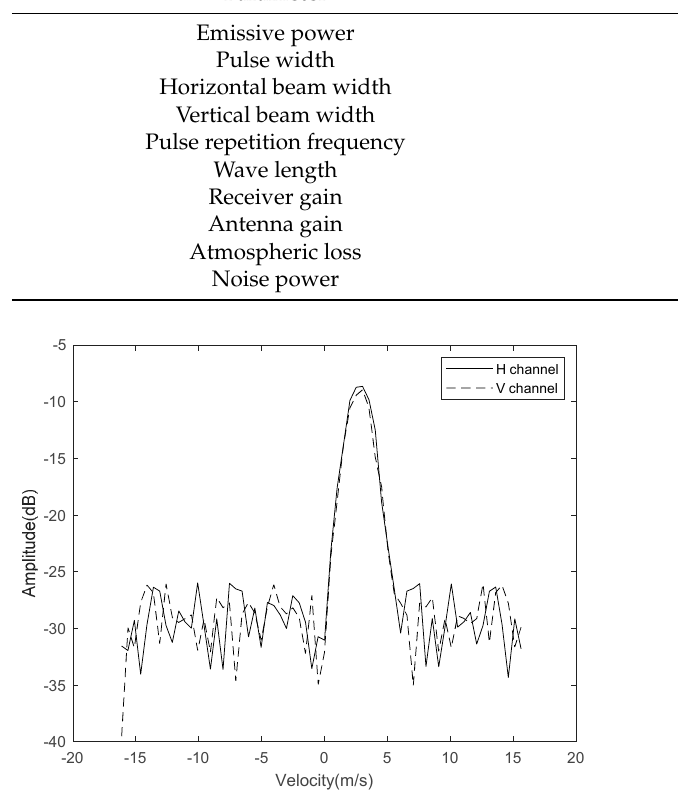
Figure 3. Power spectrum of H − channel and V − channel of simulation signal.